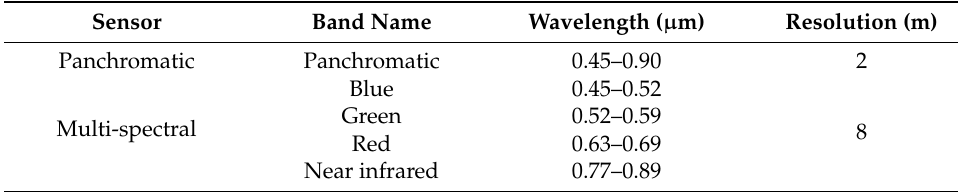
Table 1. Characteristics of the GF-1 panchromatic/multi-spectral